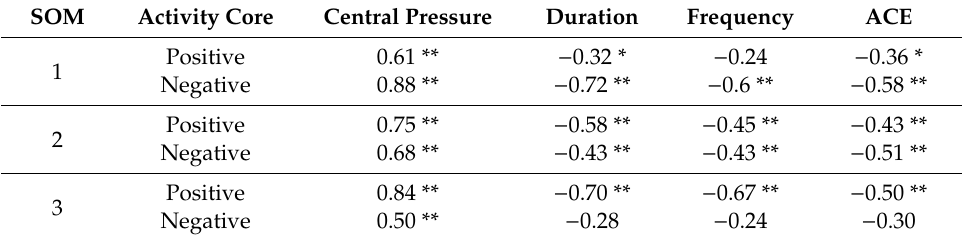
Table 2. Correlation coe ffi cients of the time series of summer-mean MSLP anomalies with three cyclone activity indices (i.e., frequency, duration, central pressure, and accumulated cyclonic energy (ACE)) for the positive and negative core areas of each SOM (dotted lines in Figure 2). All the time series were obtained by averaging within the individual core area. The significant correlations are denoted by one (* for p -value: 0.05) and two asterisks (** for p -value: 0.01) as per the two-sided Student’s t -test. SOM Activity Core Central Pressure Duration Frequency ACE Positive 0.61 ** − 0.32 * − 0.24 − 0.36 * 1 Negative 0.88 ** − 0.72 ** − 0.6 ** − 0.58 ** Positive 0.75 ** − 0.58 ** − 0.45 ** − 0.43 ** 2 Negative 0.68 ** − 0.43 ** − 0.43 ** − 0.51 ** Positive 0.84 ** − 0.70 ** − 0.67 ** − 0.50 ** 3 Negative 0.50 ** − 0.28 − 0.24 −